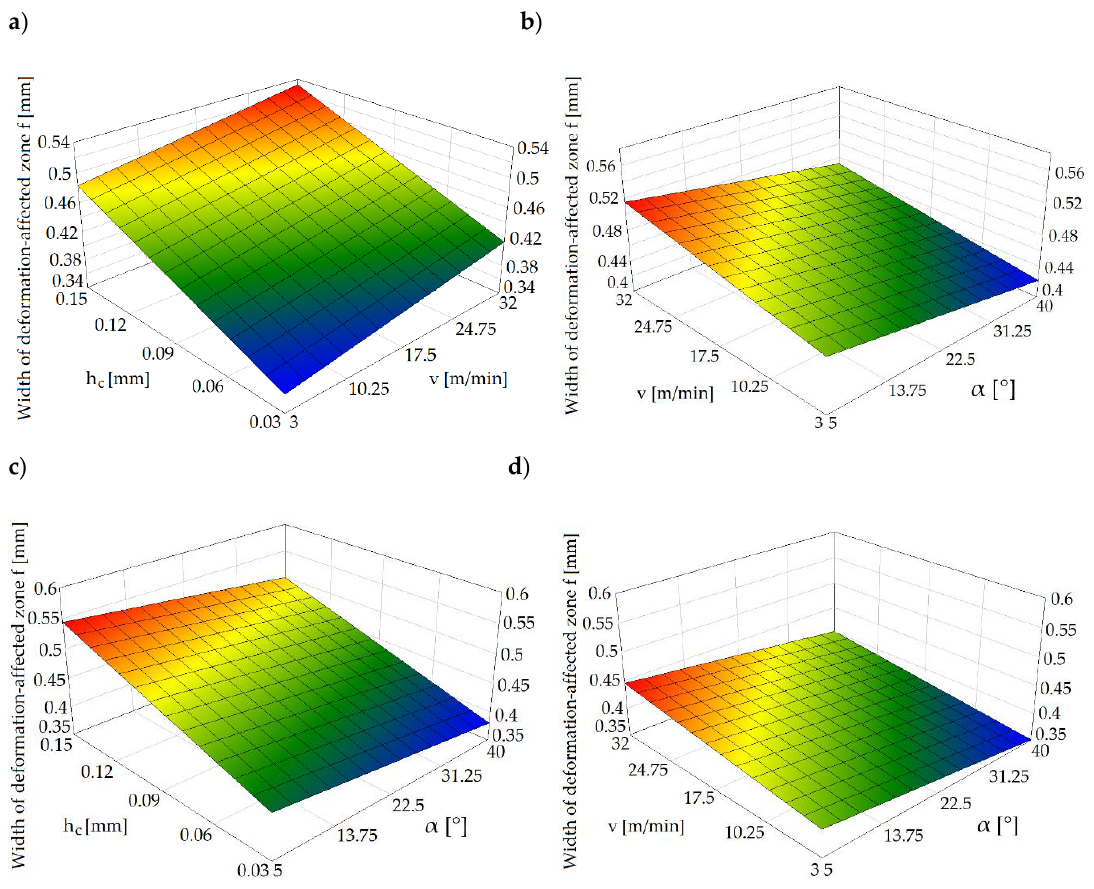
Figure 5. Graphs of the deformation-affected zone’s width for: ( a ) α = 30 ° , ( b ) h c = 0.1 mm, ( c ) v = 20 m / min, ( d ) h c = 0.03 mm.